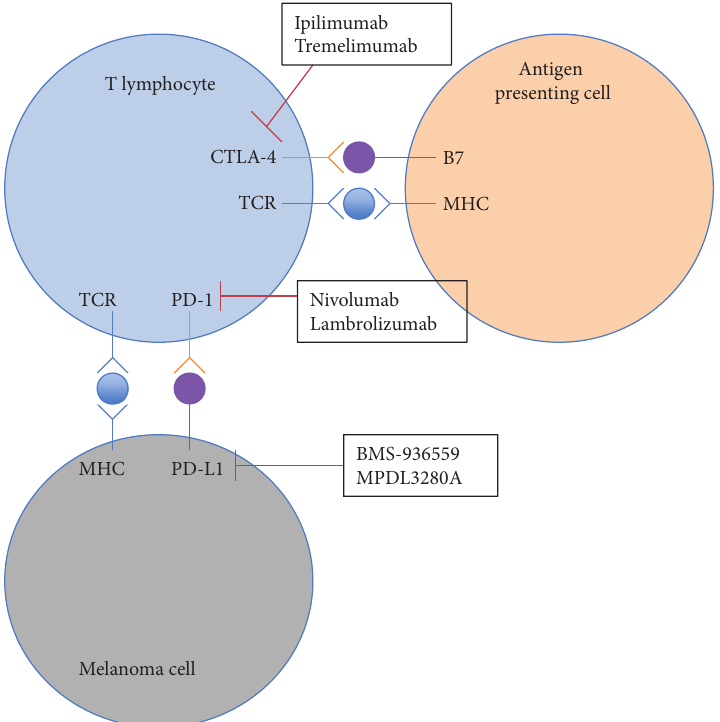
Figure 2: Important immune-checkpoint interactions and relevant inhibitory antibodies in current